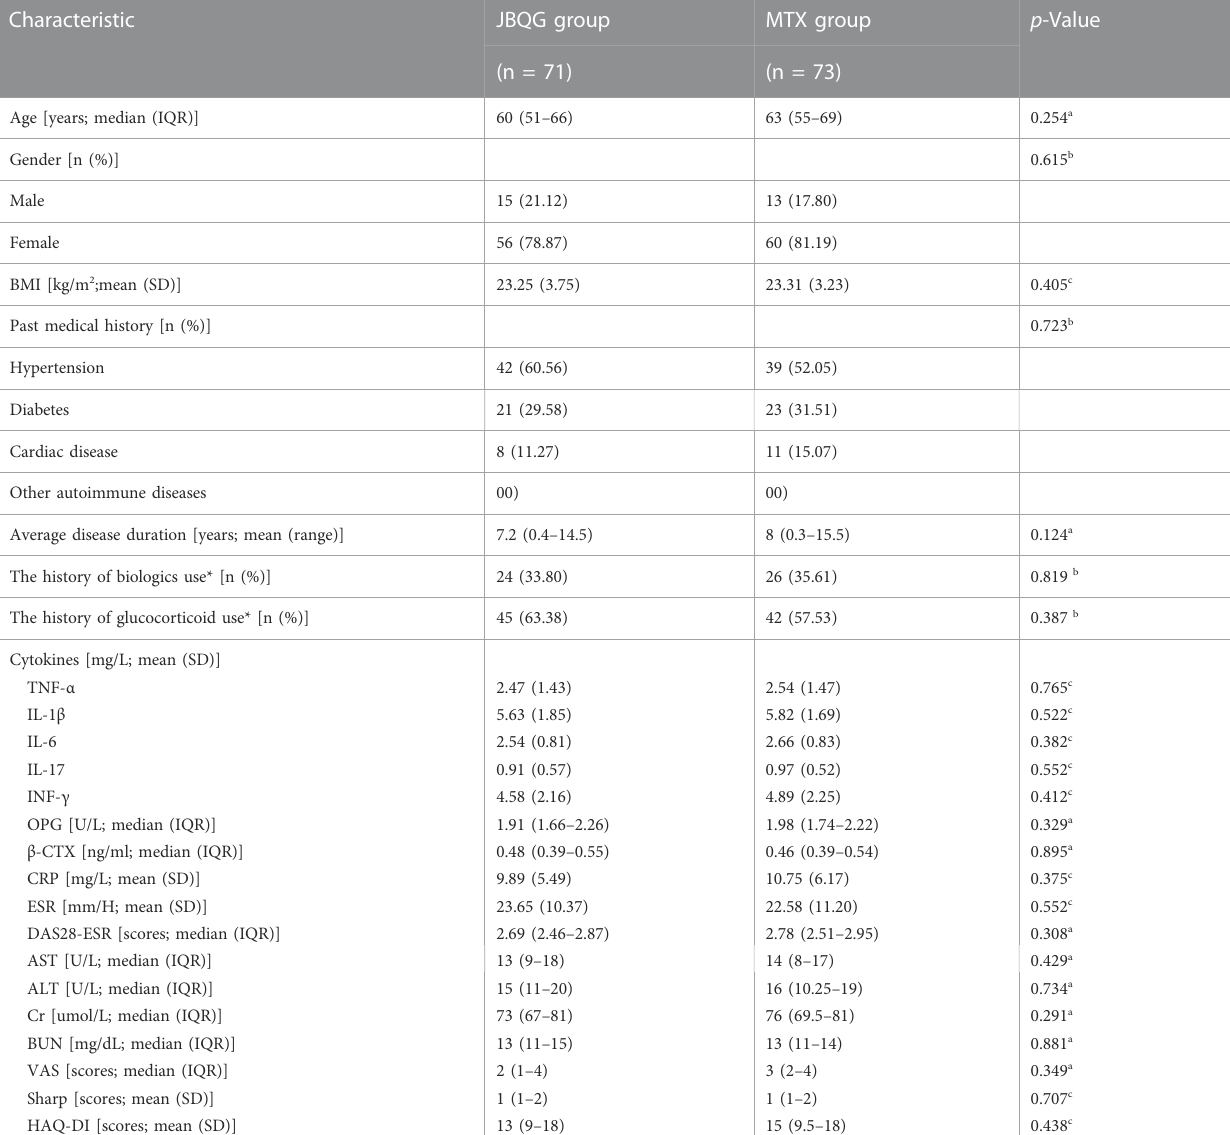
TABLE 1 Baseline characteristics of two patient